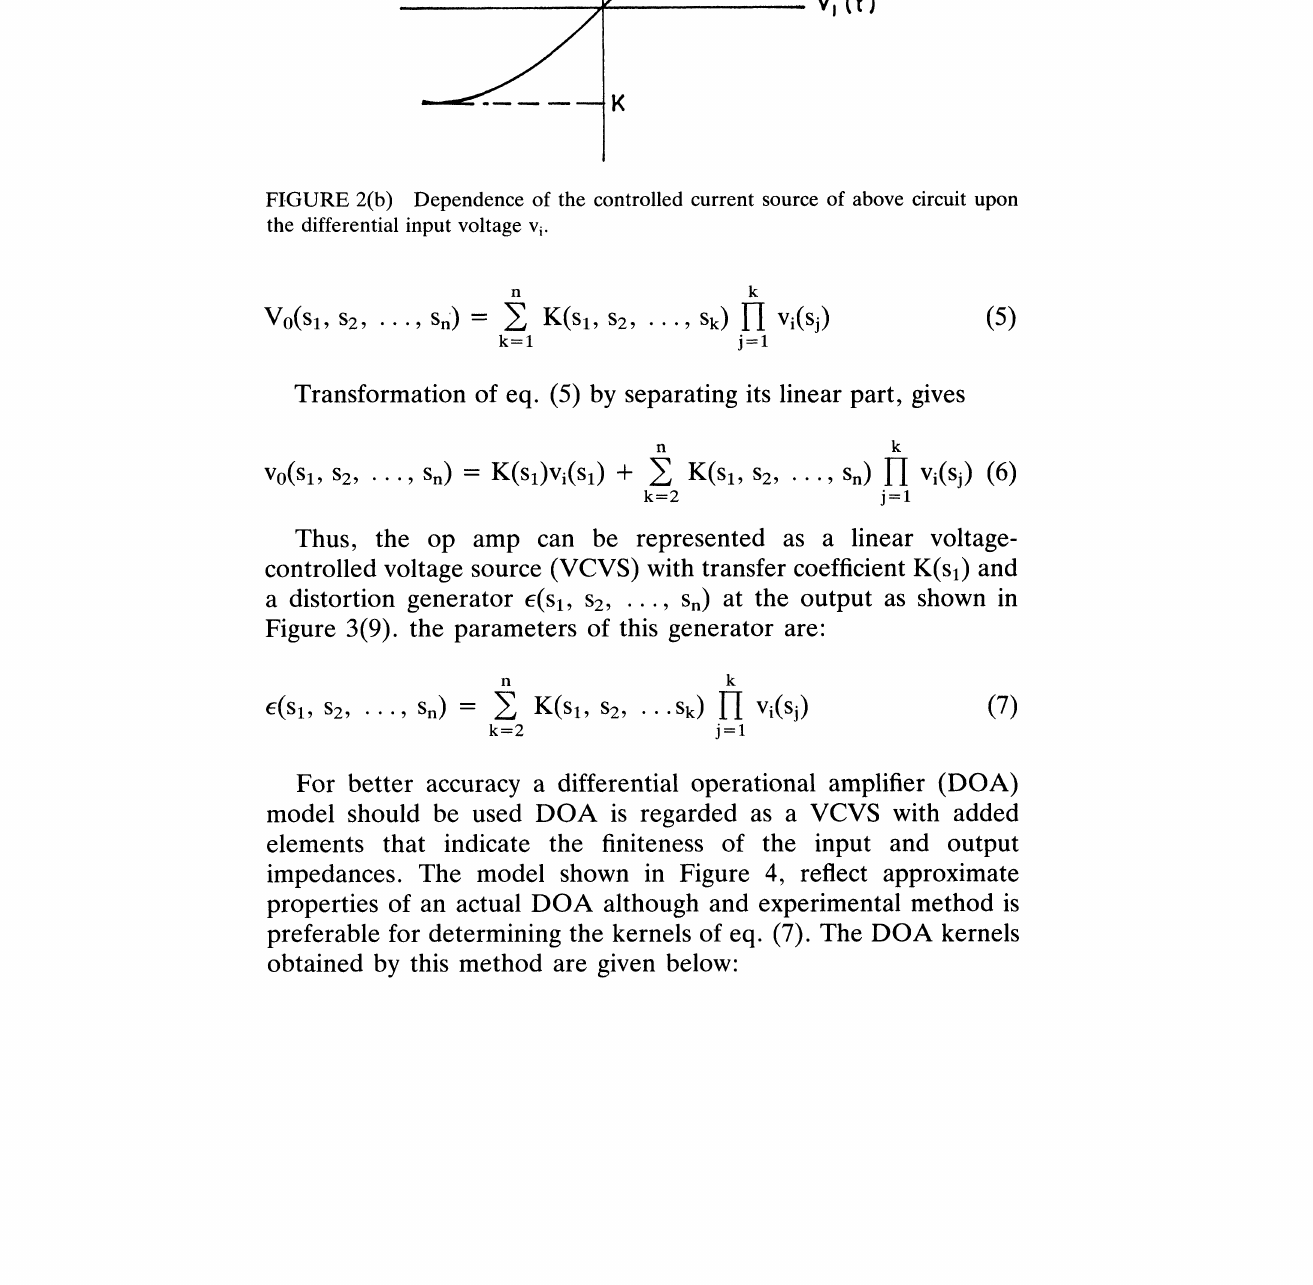
FI.GURE 2(b) Dependence of the controlled current source of above circuit upon the differential input voltage